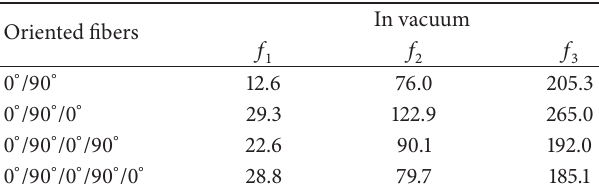
Table 1: Natural frequencies 𝑓 (Hz) of the fin in the case of 0 ∘ /90 ∘ /0 ∘ /90 ∘ /0 ∘ .